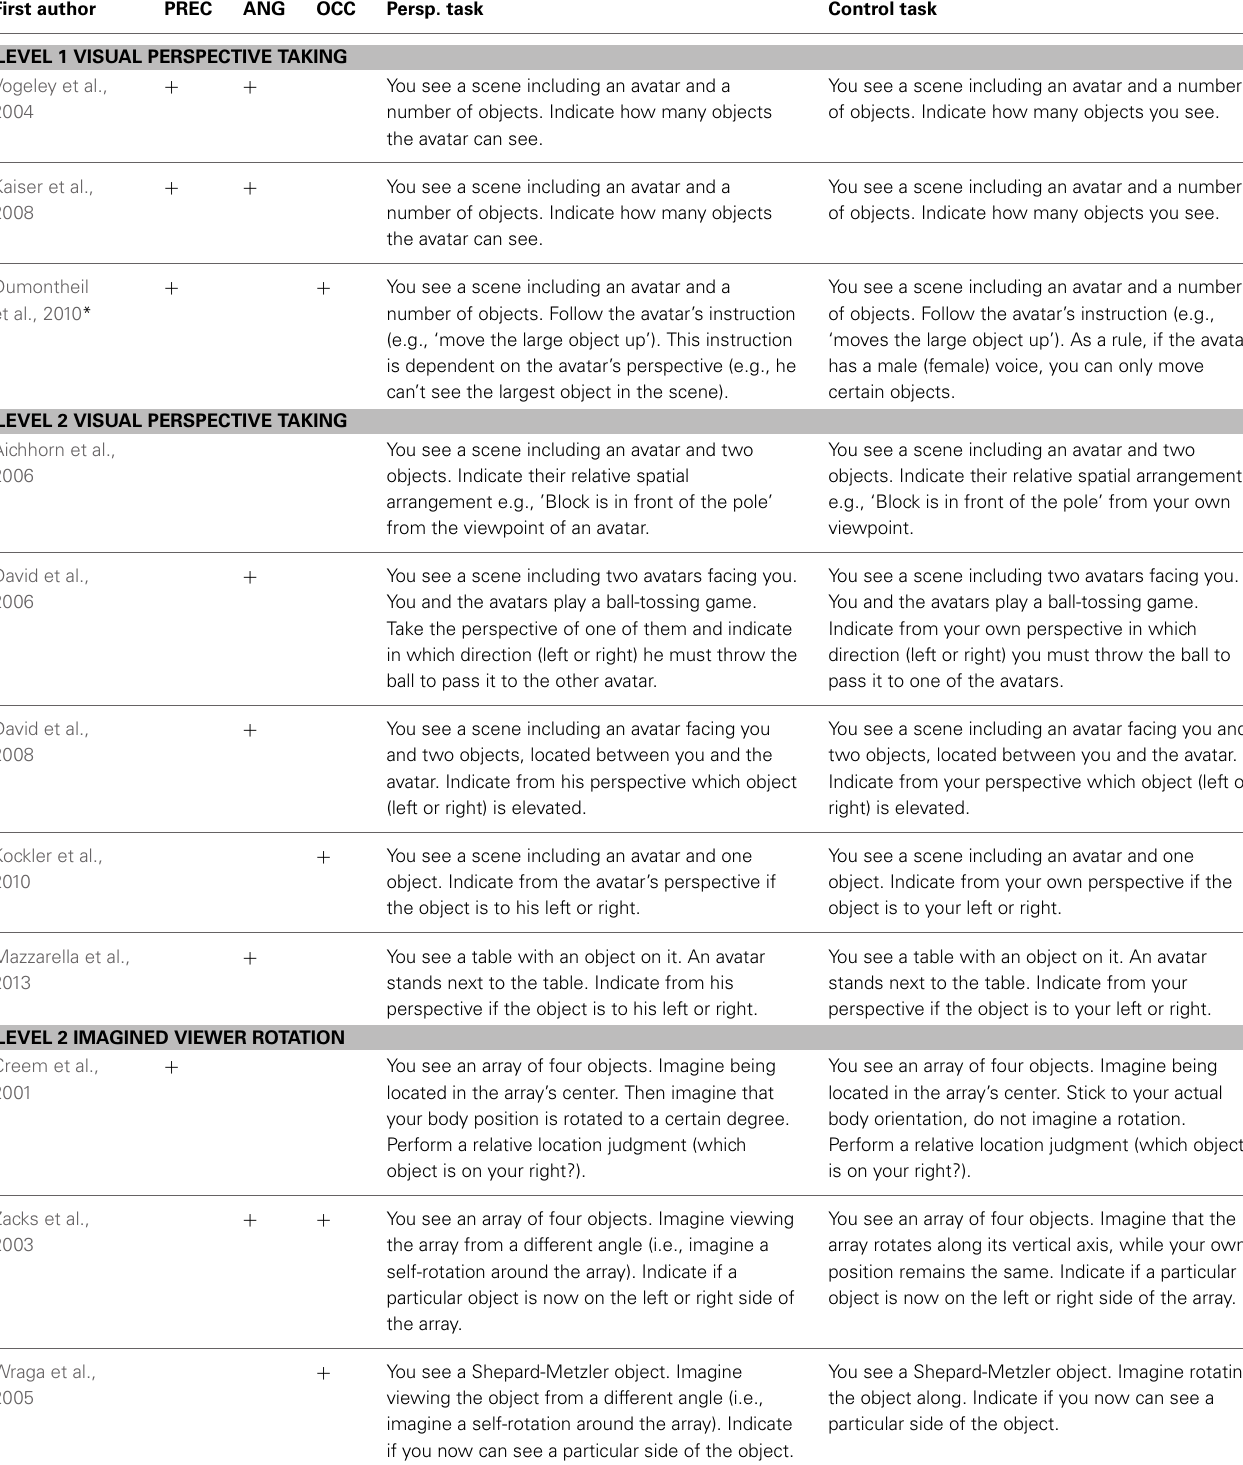
Table 3 | ROI-based follow-up review: + signs denote that a study reported activation within 20mm distance to a peak of our meta-analytic conjunction (20mm corresponds to the smoothness of